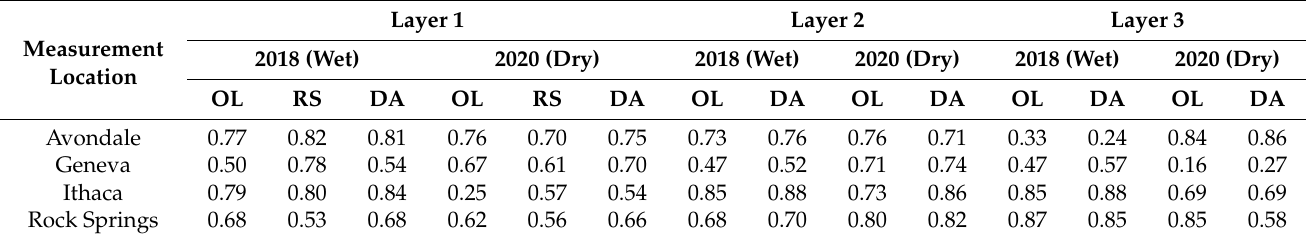
Table 3. Correlation coefficient (R) values for individual in-situ measurement locations, calculated between in-situ soil moisture observations and open loop model runs (OL), remotely sensed SMAP data (RS), and post-assimilation model runs